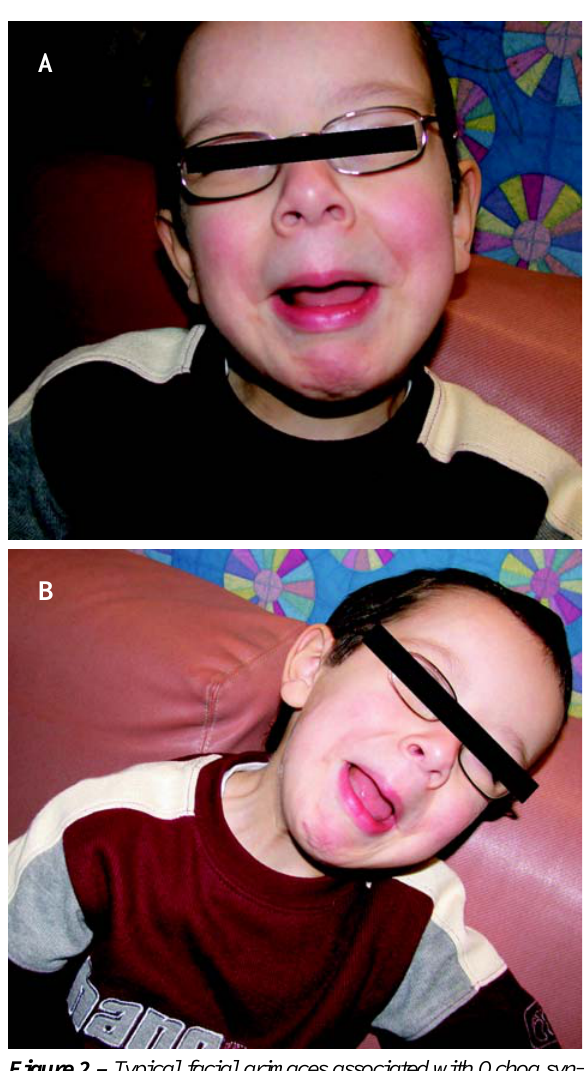
Figure 2 – Typical facial grimaces associated with Ochoa syn-